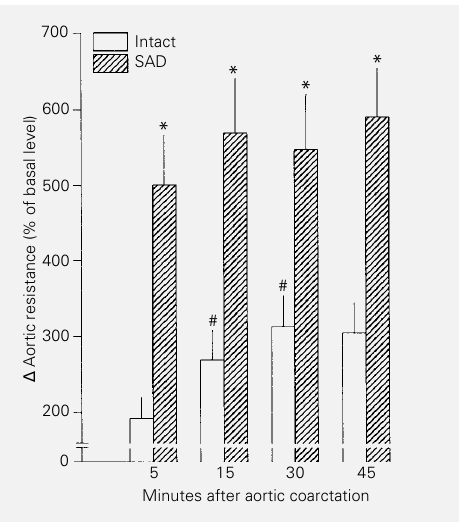
Figure 3 - Bar graph showing change as percentage of basal level ( D %) in calculated aortic re- sistance due to aortic coarcta- tion in conscious unrestrained intact and sinoaortic denervated (SAD) rats. Data are reported as means ± SEM. *P<0.05 com- pared to the corresponding point in the intact group (Student t - test); # P<0.05 compared to the anterior value in the same group (Student t